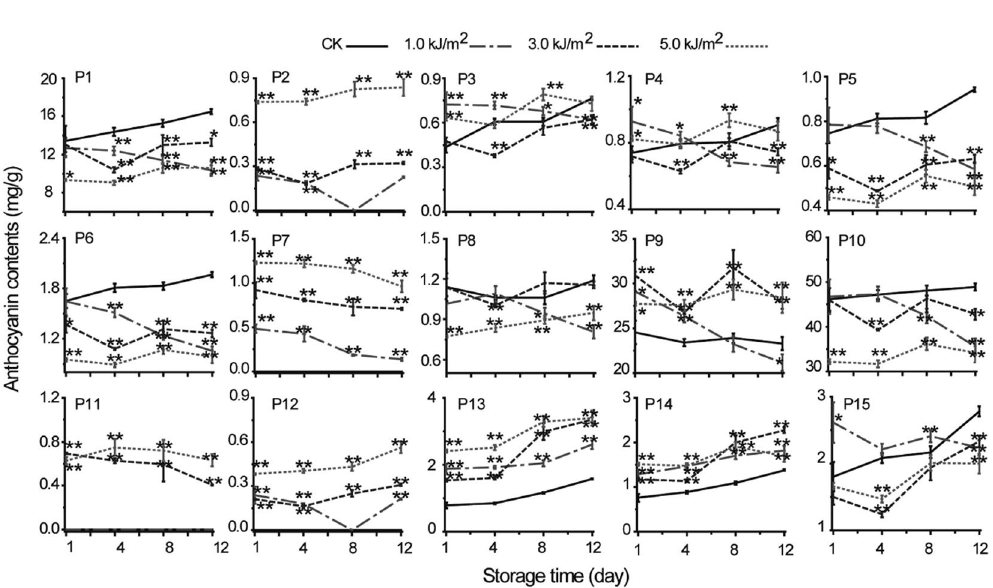
Figure 2. The accumulation of each anthocyanin compound assessed during the storage period following different UV-C treatment doses. The content (mg/g dry weight) of each anthocyanin (P1–P15, representing peaks 1–15, respectively) during the period of storage (from 1 to 12 days) following different UV-C doses (0, 1.0, 3.0, 5.0 kJ/m 2 ). Compound identification assignments are presented in Table 1. The graph shows the average values of three independent experiments with error bars indicative of the standard deviation (SD). * P < 0.05; ** P <